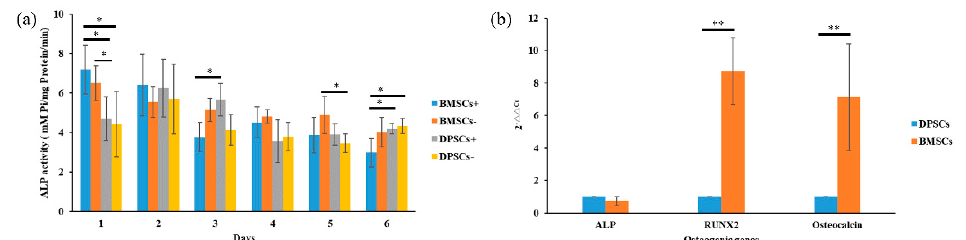
Figure 5. Comparison of ALP (alkaline phosphatase) activity and osteogenesis-related gene expression of BMSCs and DPSCs. ( a ) The expression of ALP activity of the BMSCs and DPSCs in differentiation media and regular culture medium was evaluated after 1, 2, 3, 4, 5 and 6 days of culture. ( b ) The relative osteogenic lineage gene expression levels (ALP, RUNX2 (runt related transcription factor 2), and Osteocalcin) of the BMSCs and DPSCs were assessed by qRT-PCR (* p < 0.05, ** p < 0.01).